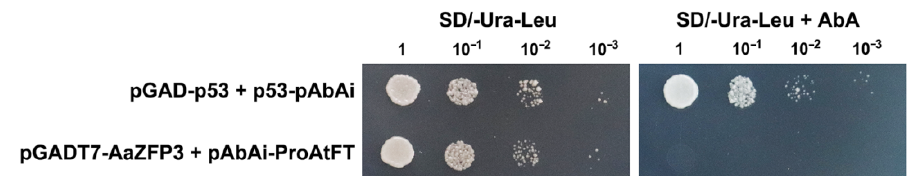
Figure 8. Yeast one hybrid (Y1H) assay of AaZFP3 binding to AtFT promoter. The full lengths of AaZFP3 and AtFT promoter (1907 bp) were constructed pGADT7 and pAbAi vectors, respectively, and they were subsequently cotransformed with yeast strain Y1HGold. Transformed yeast was grown in SD/-Ura-Leu media with or without AbA (0.6 mg L − 1 ). The pGAD-p53 + p53-pAbAi was used as a positive control. Pro: